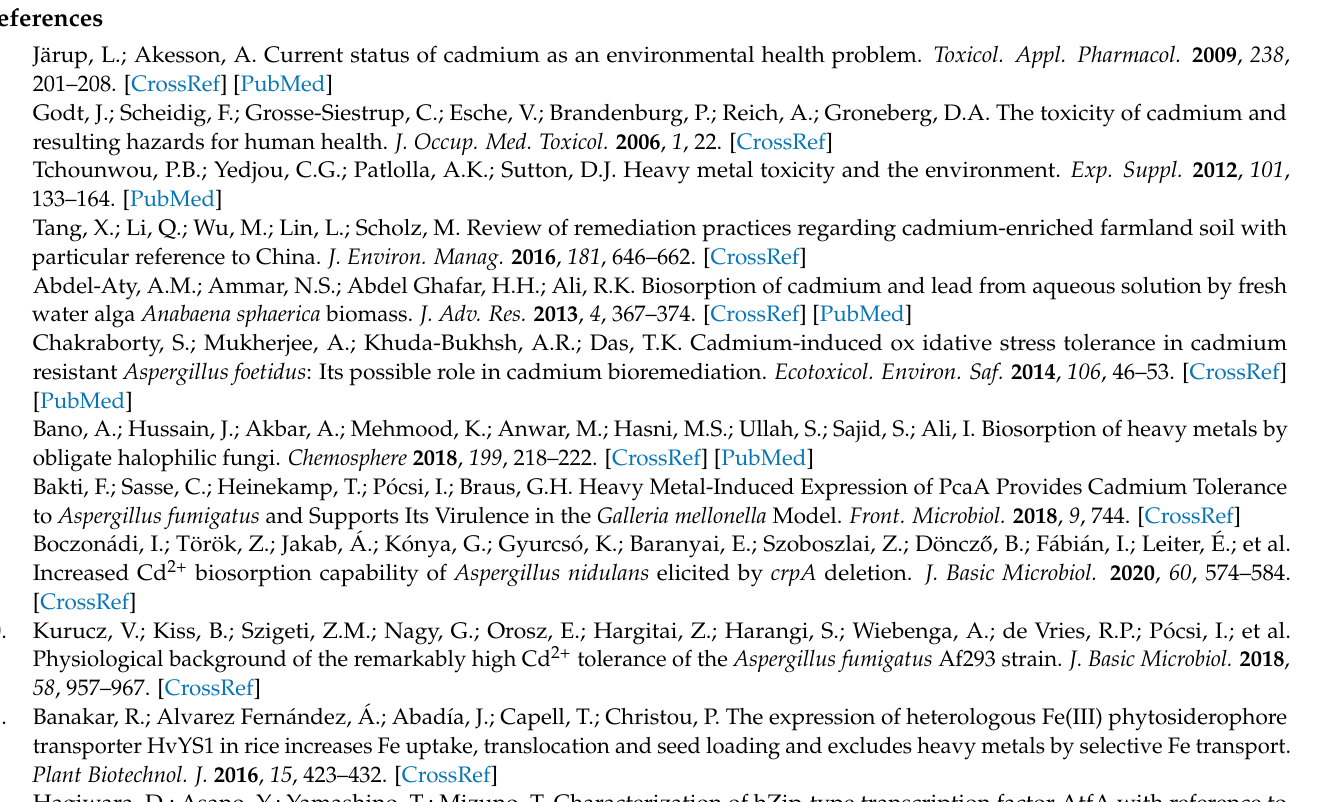
Figure S6: Changes in the transcription of selected “Folate cycle” genes, Figure S7: Changes in the transcription of genes encoding known and putative catalases, Table S1: RT-qPCR primer pairs used in the study, Table S2: Read mapping statistics, Table S3: RT-qPCR data of the selected genes, Table S4: Significantly enriched FunCat, GO, and KEGG pathway terms. Table S5: RNAseq data and the results of enrichment analyses of the studied gene groups, Table S6: Results of the promoter